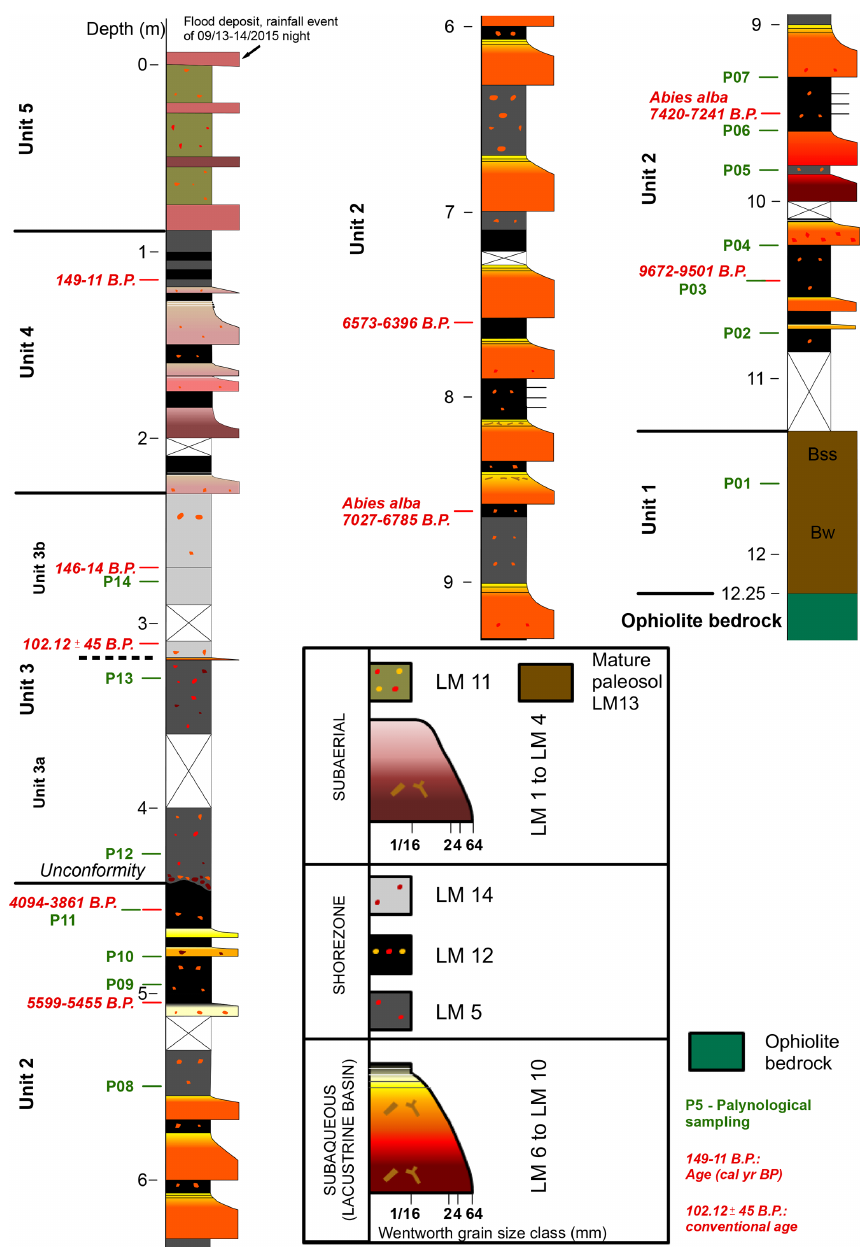
Figure 3. Sedimentological features and lithofacies characterization of the reference core S1. Radiocarbon dates, palynological and grain size samples, and stratigraphic units (described in Sect. 4.2) are also